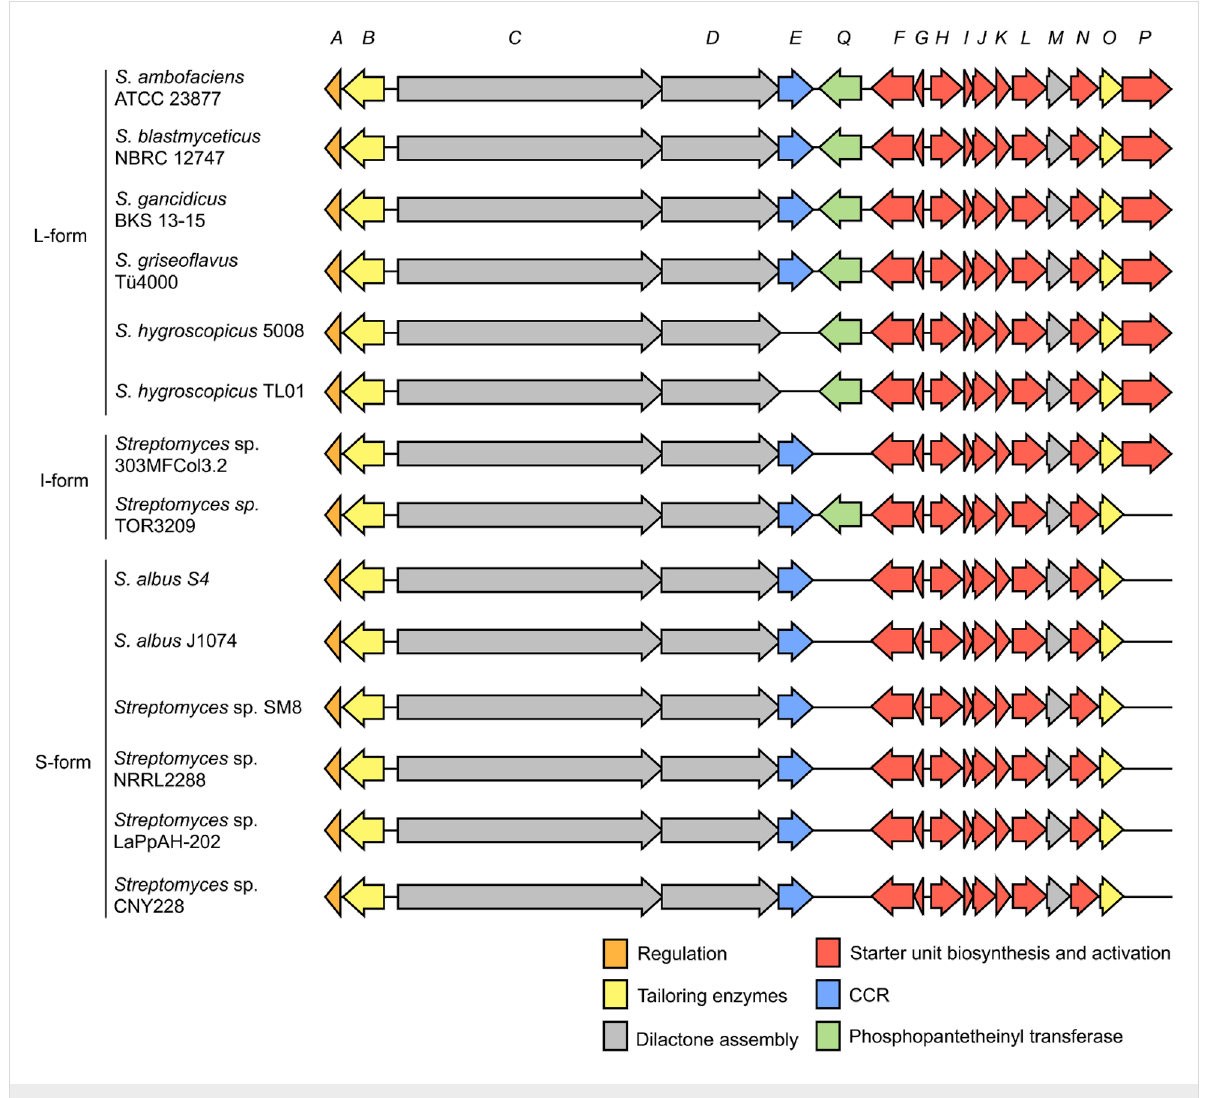
Figure 2: Schematic representation of ant biosynthetic gene clusters. L-form ant gene clusters are encoded by: S. ambofaciens ATCC 23877 (AM238663), S. blastmyceticus NBRC 12747 (AB727666), S. gancidicus BKS 13-15 (AOHP01000135, AOHP01000134, AOHP01000056, [31]), S. griseoflavus Tü4000 (ACFA01000901, ACFA01000902, ACFA01000903, ACFA01000904, ACFA01000905, ACFA01000906, ACFA01000907); S. hygroscopicus subsp. jinggangensis 5008 (NC_017765); S. hygroscopicus subsp. jinggangensis TL01 (NC_020895). I-form ant gene clusters are encoded by: Streptomyces sp. 303MFCol5.2 (ARTR01000061), Streptomyces sp. TOR3209 (AGNH01000419, AGNH01000420, AGNH01000421, [32]). S-form ant gene clusters are encoded by: S. albus S4 (CADY01000091); S. albus J1074 (NC_020990); Streptomyces sp.